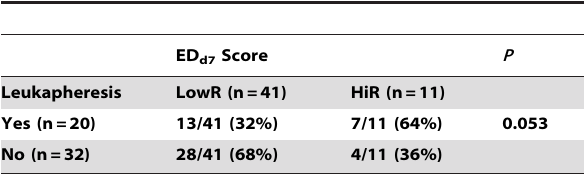
Table 7. Distribution of leukapheresis in two risk groups of the ED d7 Score.